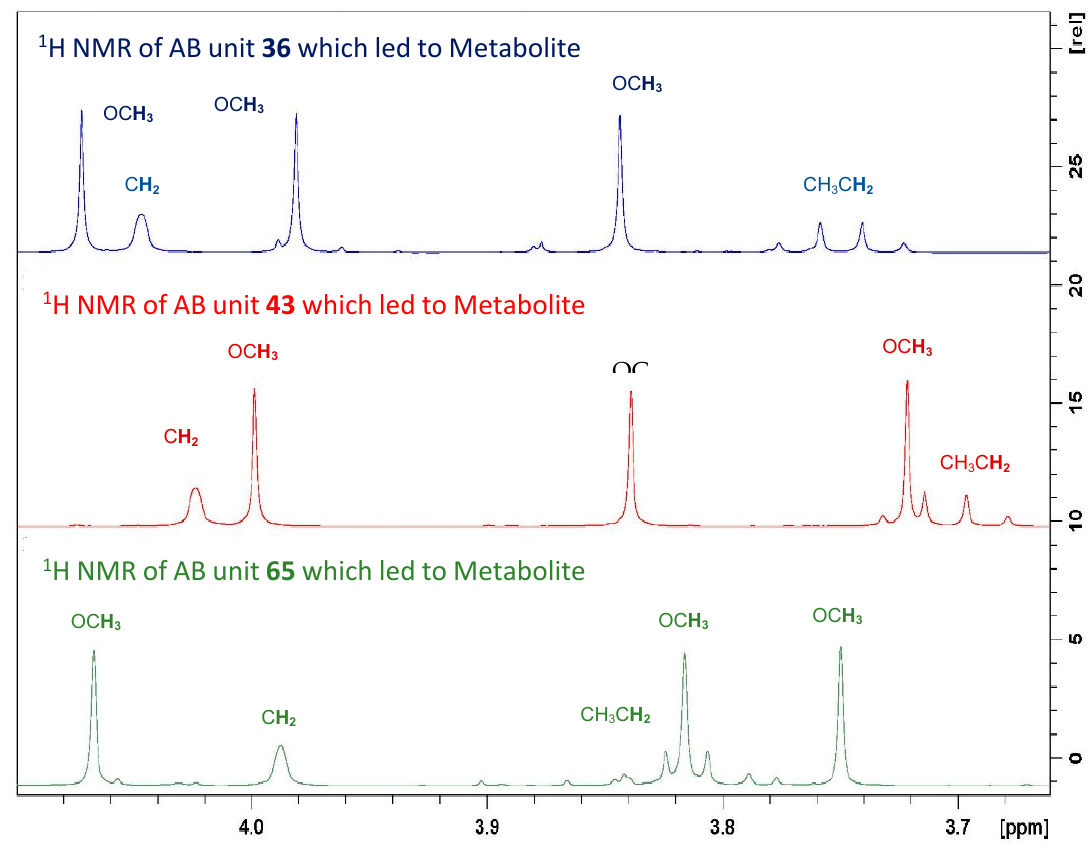
Figure 3. 1 H NMR spectrums of A/B units 36 , 43 and 65 which were used to synthesize metabolites 5A , 5B and 5C respectively.